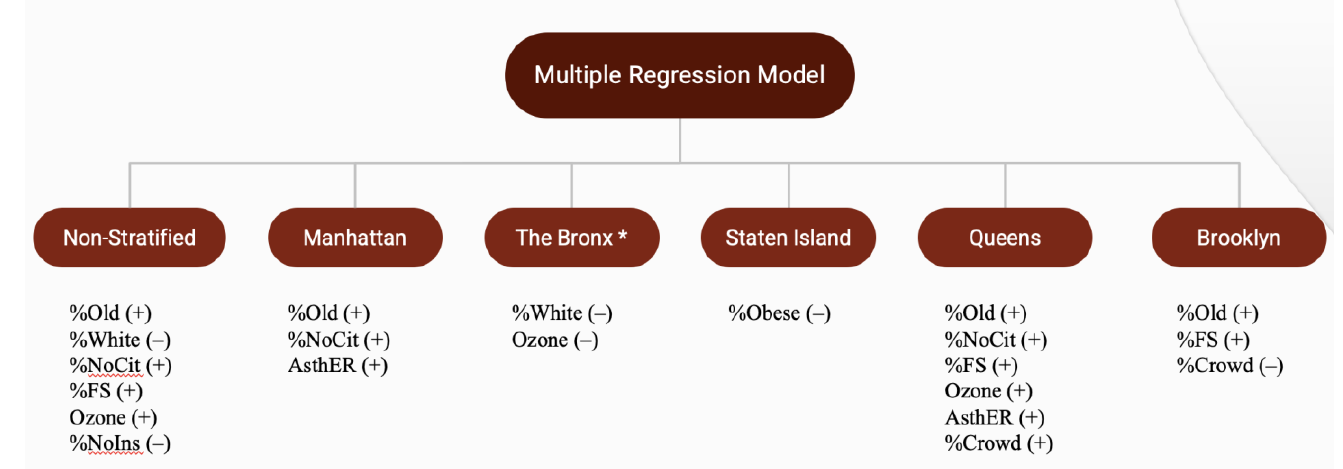
Figure 5. Summary of multiple regression of New York City COVID-19 death rate. The overall model was significant, with a p -value less than 0.001. Approximately 54.84% of the variability in the model is explained by the factors included. Significant pre- dictors of COVID-19 death rate included percent 65+, percent White, percent non-US citi- zen, percent on food stamps, ozone level, and percent without health insurance.